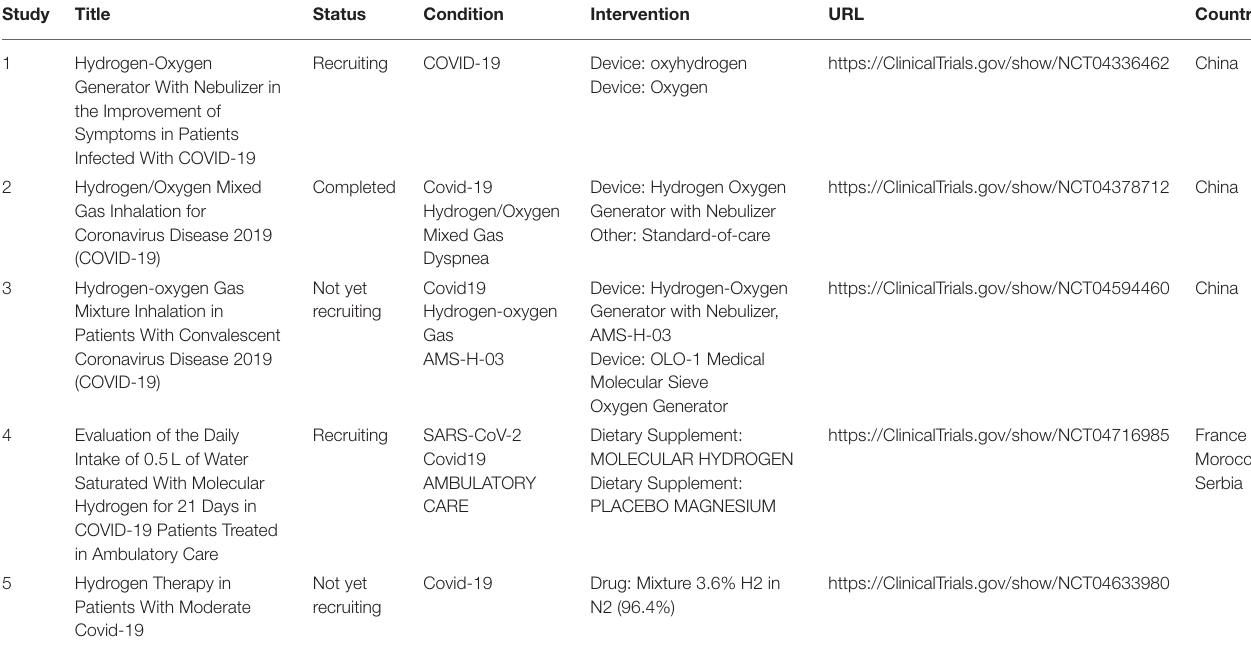
TABLE 1 | The current clinical trial about hydrogen therapy in patients with